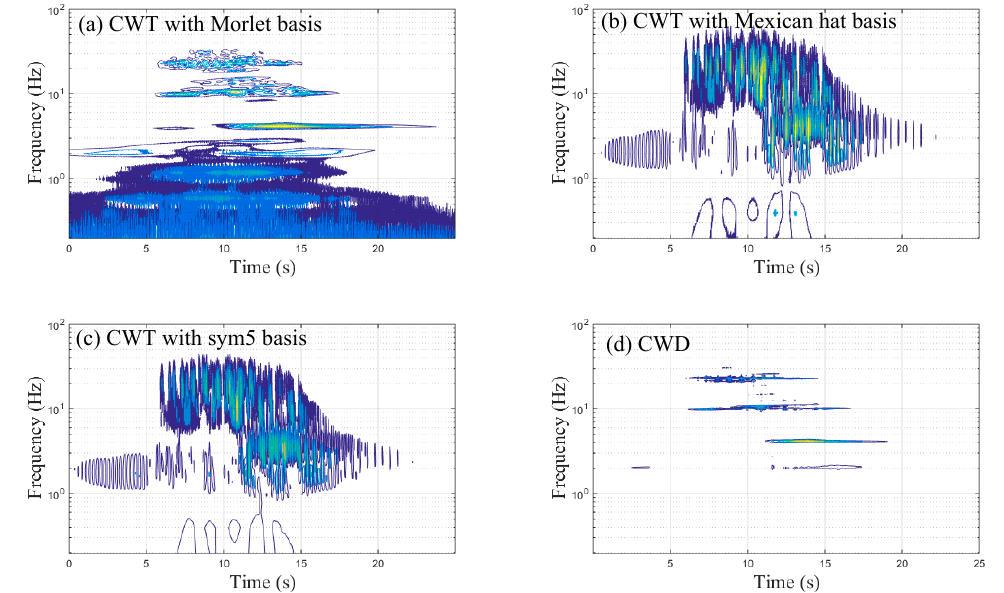
Figure 5. The time–frequency representation results of the center-point’s acceleration signals of the main span under a train speed of 120 km/h with respect to different methods: ( a ) continuous wavelet transform (CWT) with the Morlet basis; ( b ) CWT with the Mexican-hat basis; ( c ) CWT with the sym5 basis; ( d ) Choi–Williams distribution (CWD).